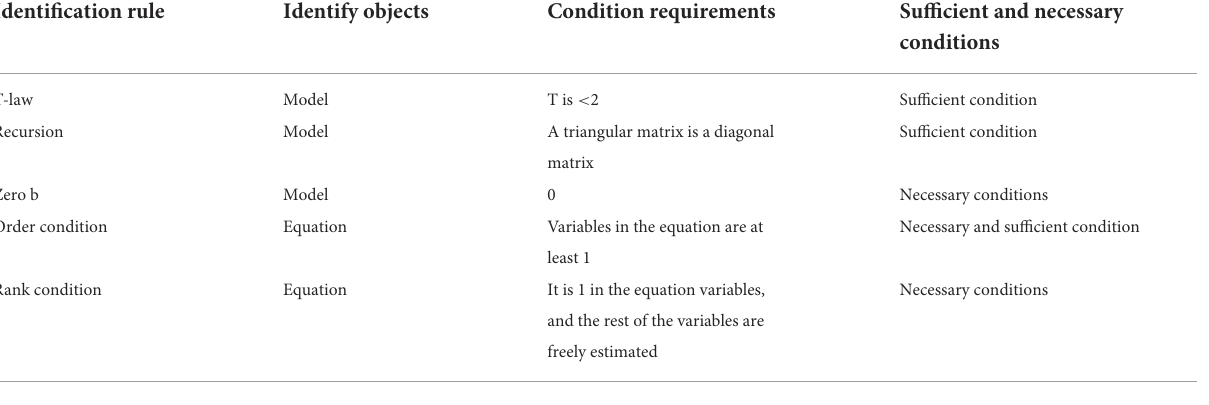
TABLE 2 Confirmatory factor